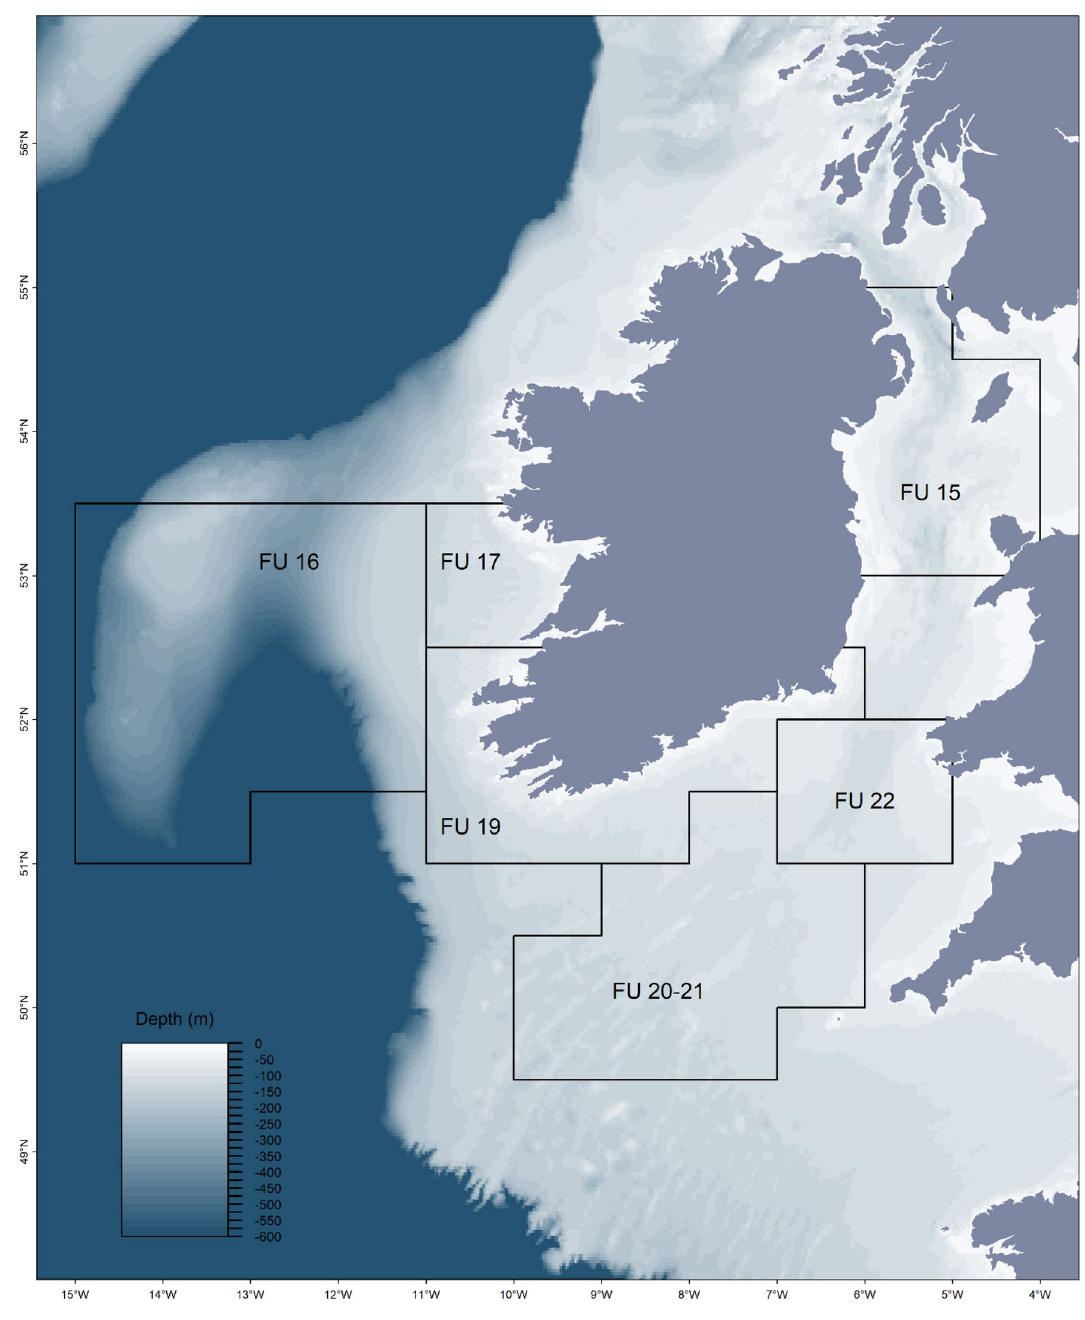
Figure 1. The UWTV survey areas around the Irish coast. Numbers represent the ICES Nephrops Functional Units (FUs), as defined by the ICES Nephrops Working Group. Depth (m) for the study areas (GEBCO bathymetry data). Map created using: R version 3.61 (2019–07-05) software, https ://tinyu rl.com/yy6rz Video-counts of door-keeping animals, defined as those with partial cephalothorax or claws were visible across the burrow mouth entrance, and animals in full emergence which were entirely visible were available 10,15 . As with burrow systems, densities of animals in door-keeping and full emergence were obtained for each transect by dividing respective counts by the video-swept surface. Each density estimate for burrow systems and animals in both behavioural categories was associated to a time stamp, represented by the time at mid transect length. All density data were grouped per depth ranges within the upper and lower shelf, based on the previous knowledge from trawl catch patterns 11,41,42 nominally as: 15–50, 51–100, 101–160 and 340–570 m. No data were available for 161–339 m depth. Data for the bathymetric range 340–570 m were only available in FU 16 for the years 2012 and 2013, and this inclusion was necessary to characterize behavioural rhythms in the deepest range for comparison with shallow shelf observations (as previously done with trawling 11 ).